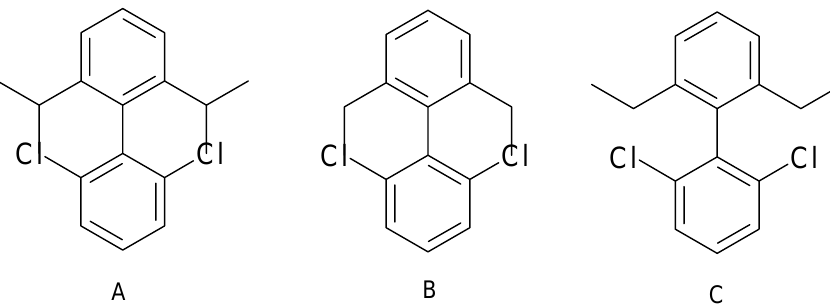
Figure 5. Structures containing overlapped fragments (A and B) and the lack of overlapping